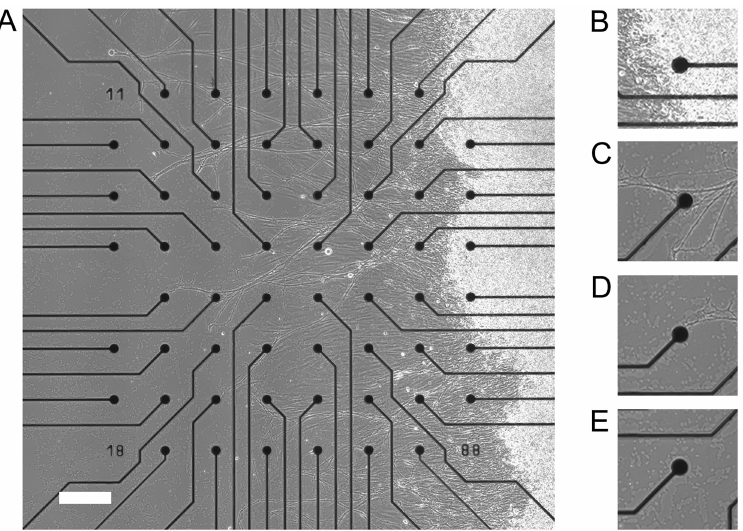
Fig 1. High resolution phase contrast photomicrograph of DRG tissue seeded on a microelectrode array after a 2 day culture. (A). 59 extracellularelectrodes were visuallyclassified as having contact with a DRG soma (B) or a DRG neurite (C). For some electrodesit was unclear if there was DRG neurite contact (D) and electrodes devoidof contact with DRG tissue were classifiedas CLEAN (E). The majority of electrodes classifiedas CLEAN were locatedon the oppositeside of the array from where the DRG tissue was located (left side of A; scale bar = 200 μ m).